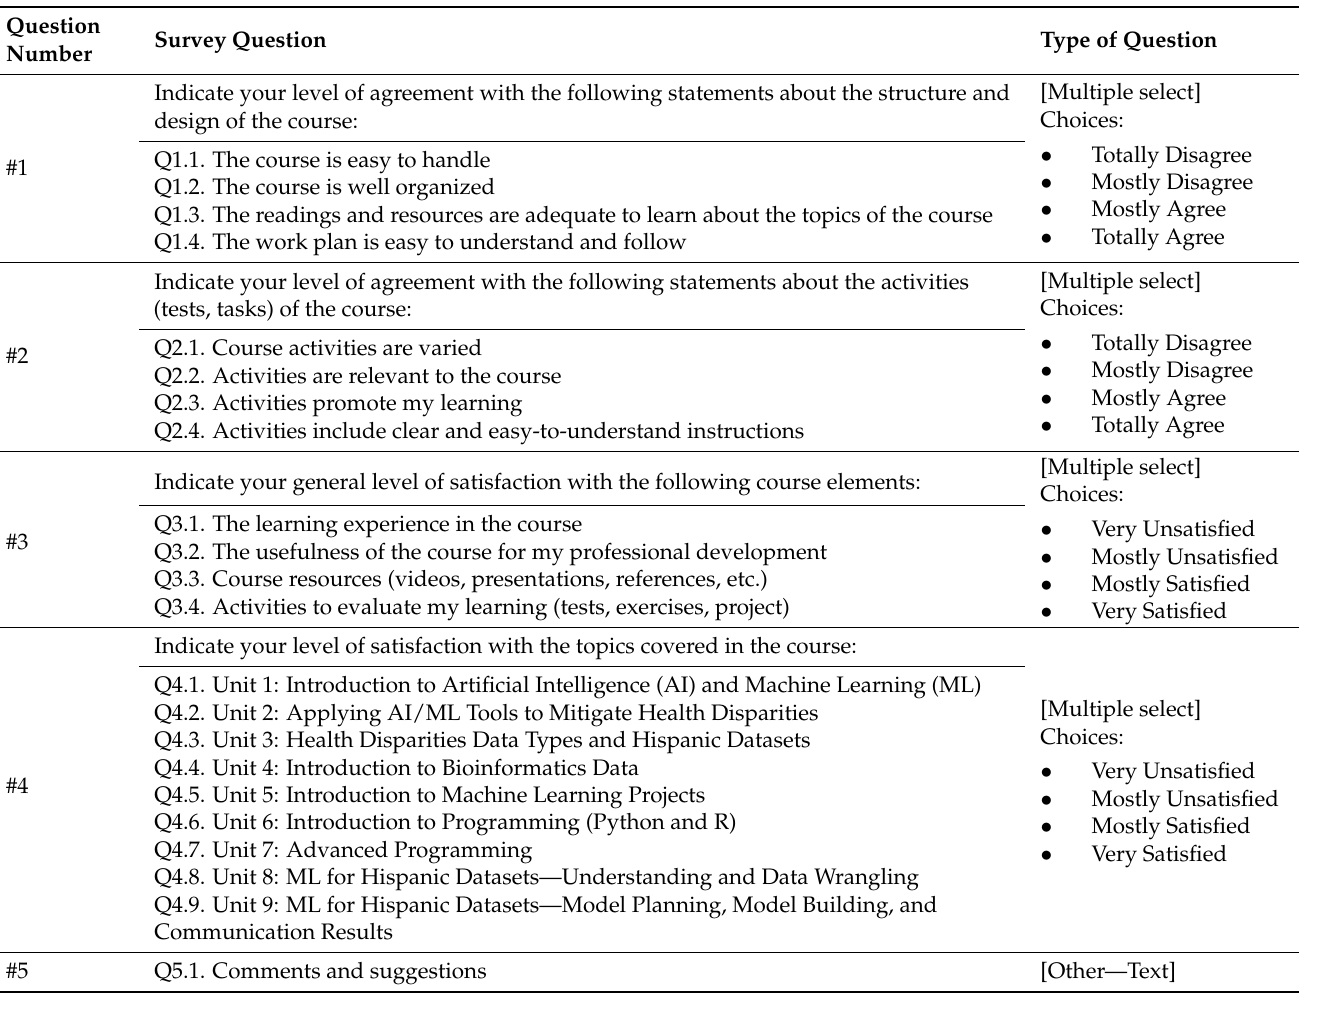
Table 2. Course participants